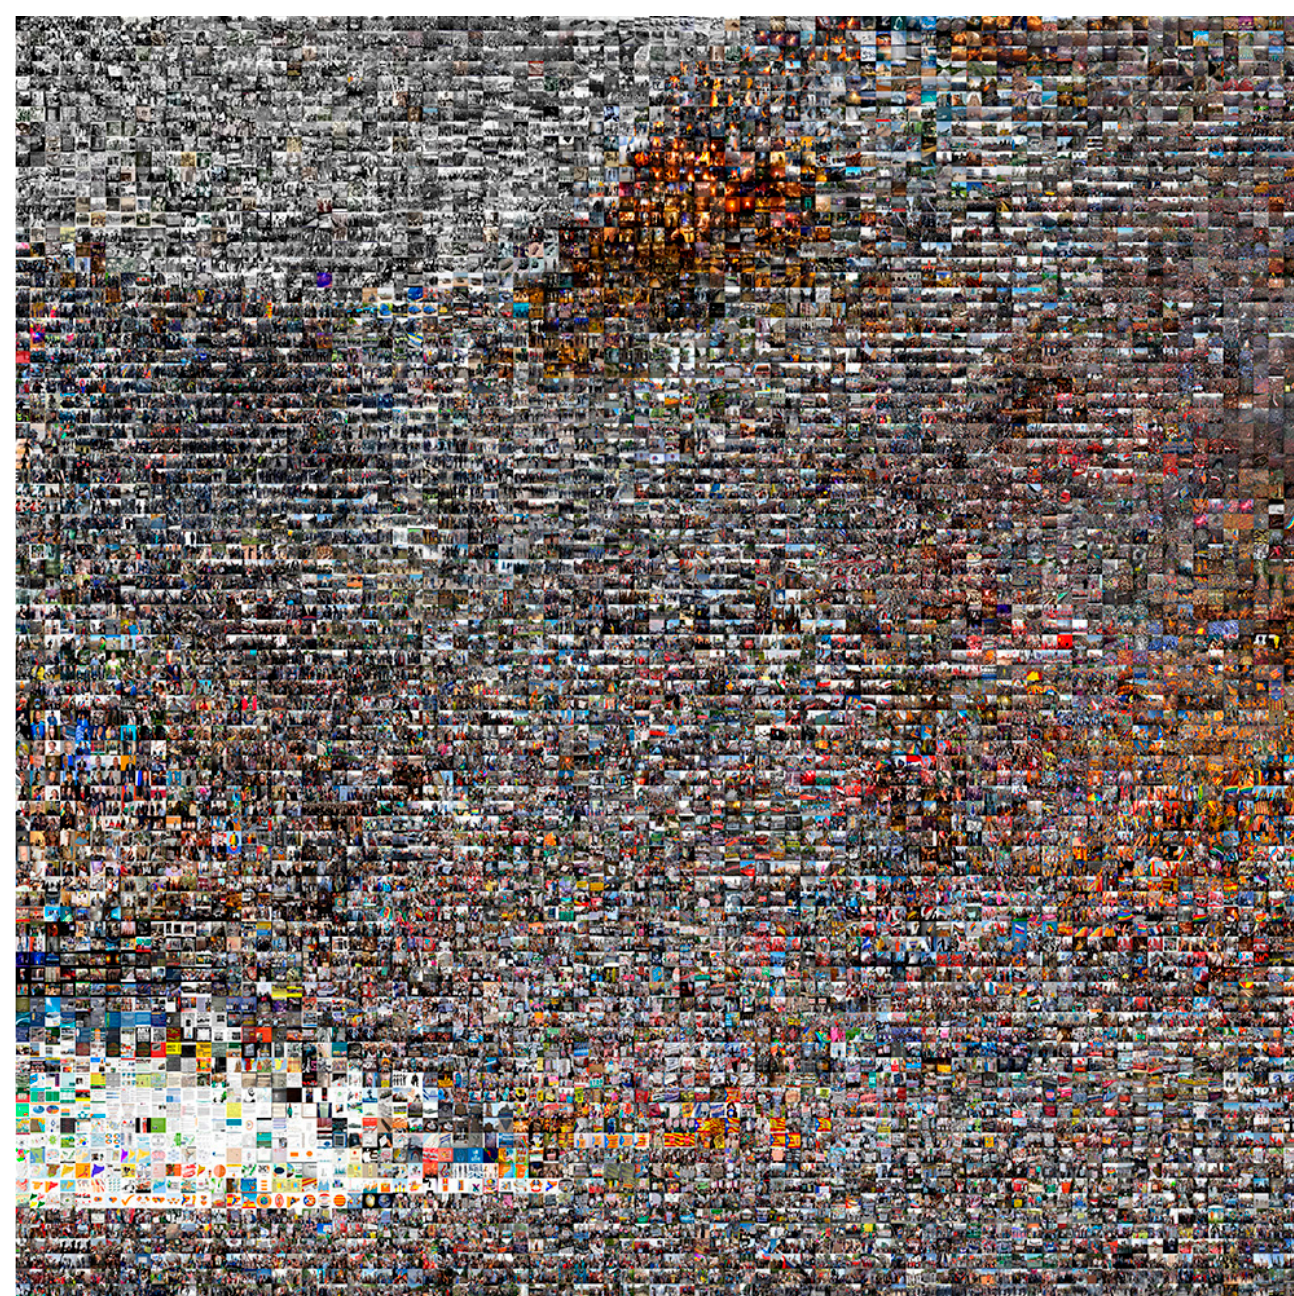
Figure 4 . Digital image containing 10,000 images of demonstrations in different countries all over the world (2 × 2 m). © Pilar Rosado.